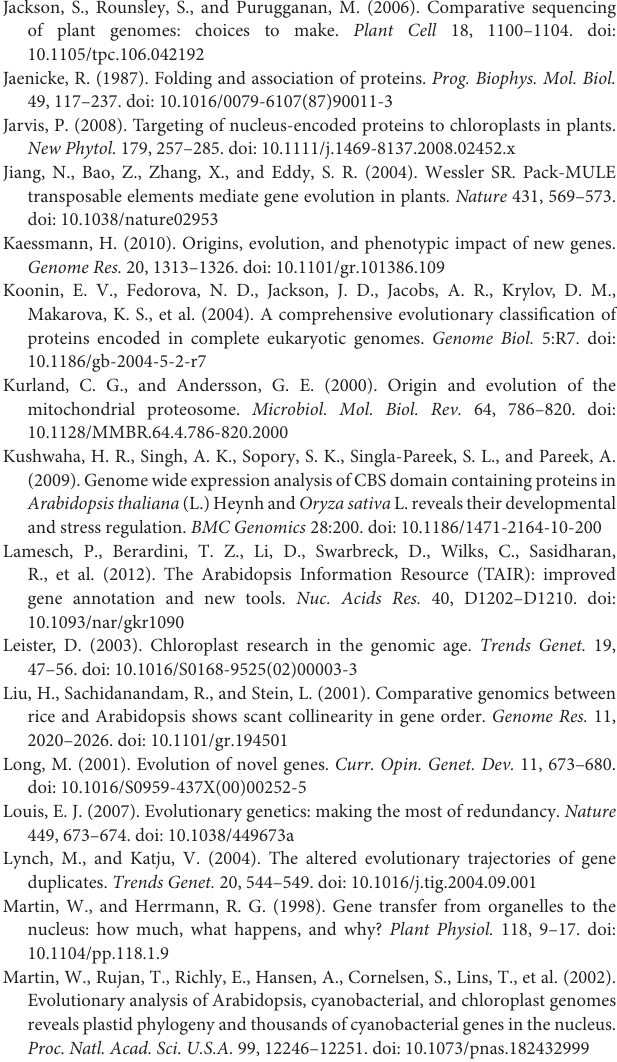
Supplementary Table 1 | List of old “prokaryotic” proteins identified in Arabidopsis and Oryza sativa . Supplementary Table 2 | Common domain arrangement identified in old “prokaryotic” proteins in Arabidopsis and Oryza sativa along with their respective functions in the two